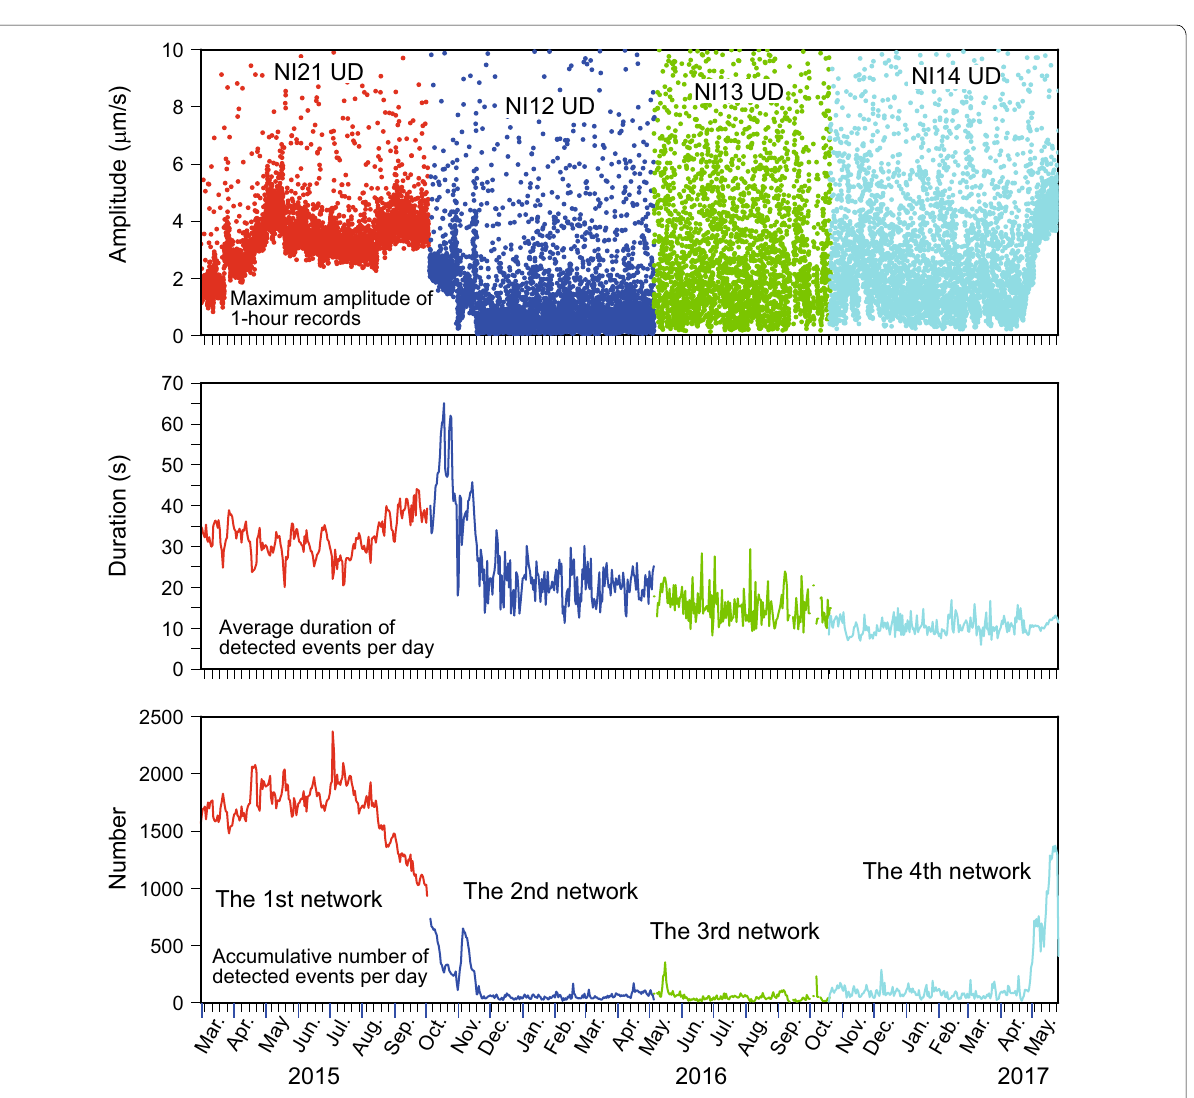
Fig. 5 Nishinoshima volcano activity from March 2015 to May 2017 estimated using LT-OBS observations. Top: temporal variation in the amplitudes of the vertical component for NI21, NI12, NI13, and NI14. The positions of the four LT-OBSs were close and positioned southeastward of Nishi- noshima. The maximum amplitudes for each 1-h record are plotted. Middle: the average durations of events detected using the STA/LTA method in 1 day. Lower: the accumulated number of detected events using the STA/LTA method in each day. The number of events is considered to be an indication of volcanic activity on Nishinoshima. There were approximately 1800 events during the eruption and decreased starting in July 2015. From the middle of April 2017, the number increased again and reached about 1400 at the end of May